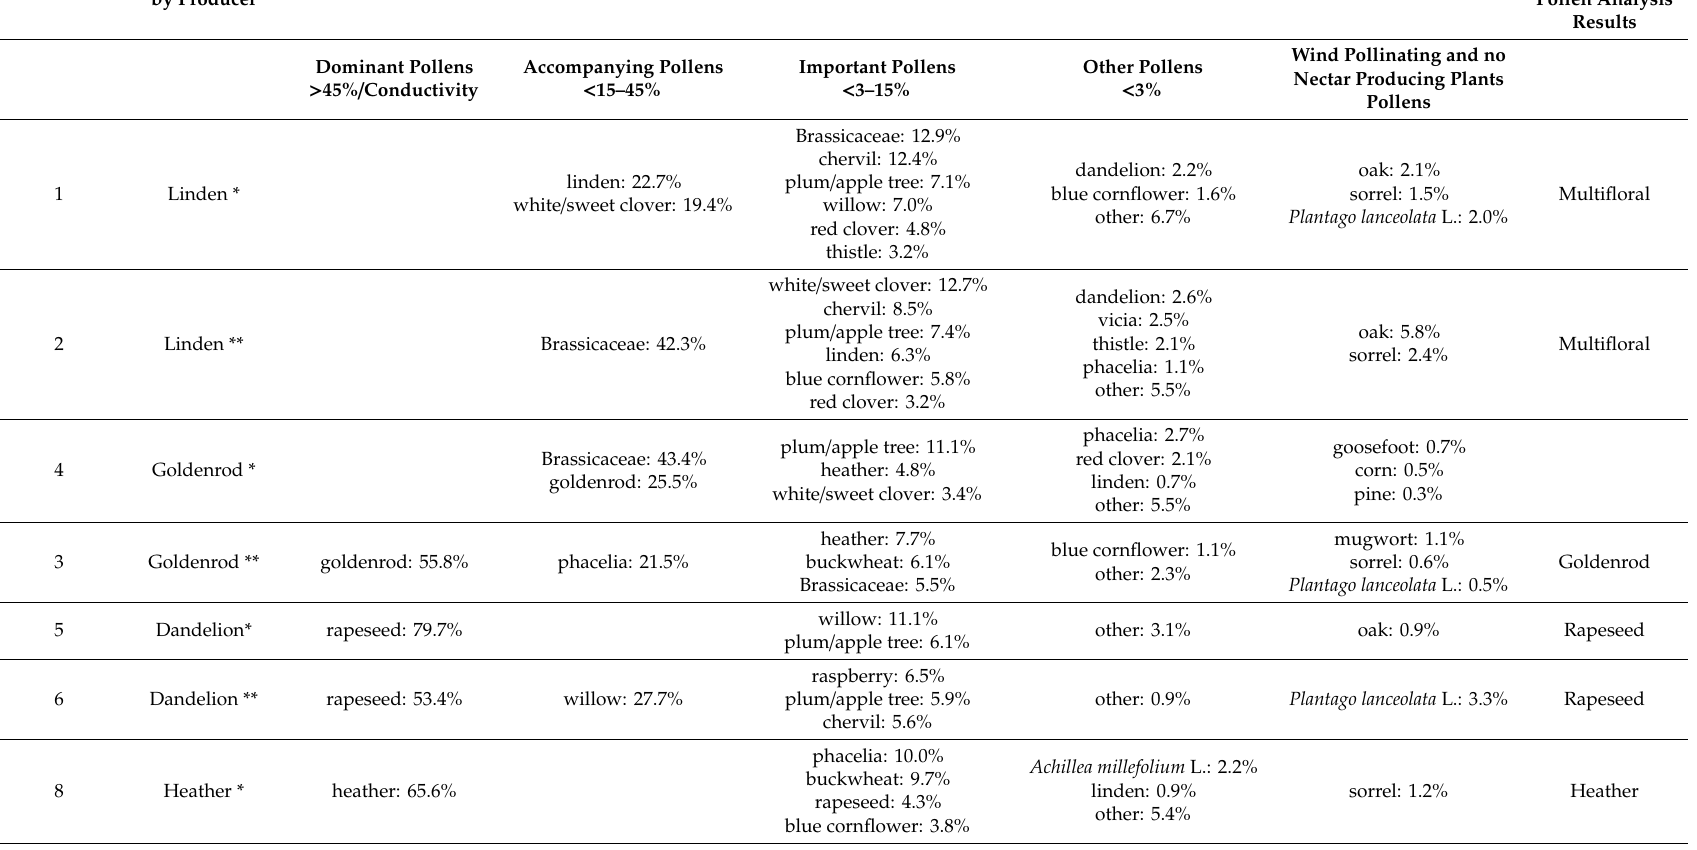
Table 1. Research material with its specific